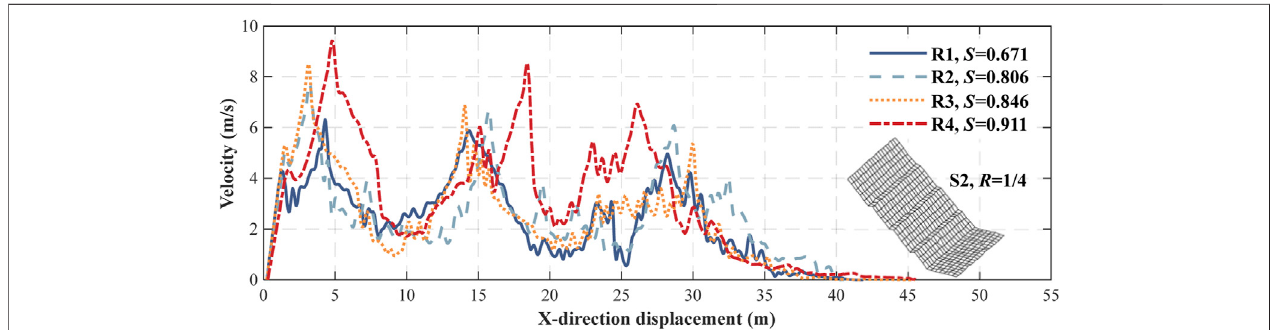
FIGURE 7 | Velocity along the x